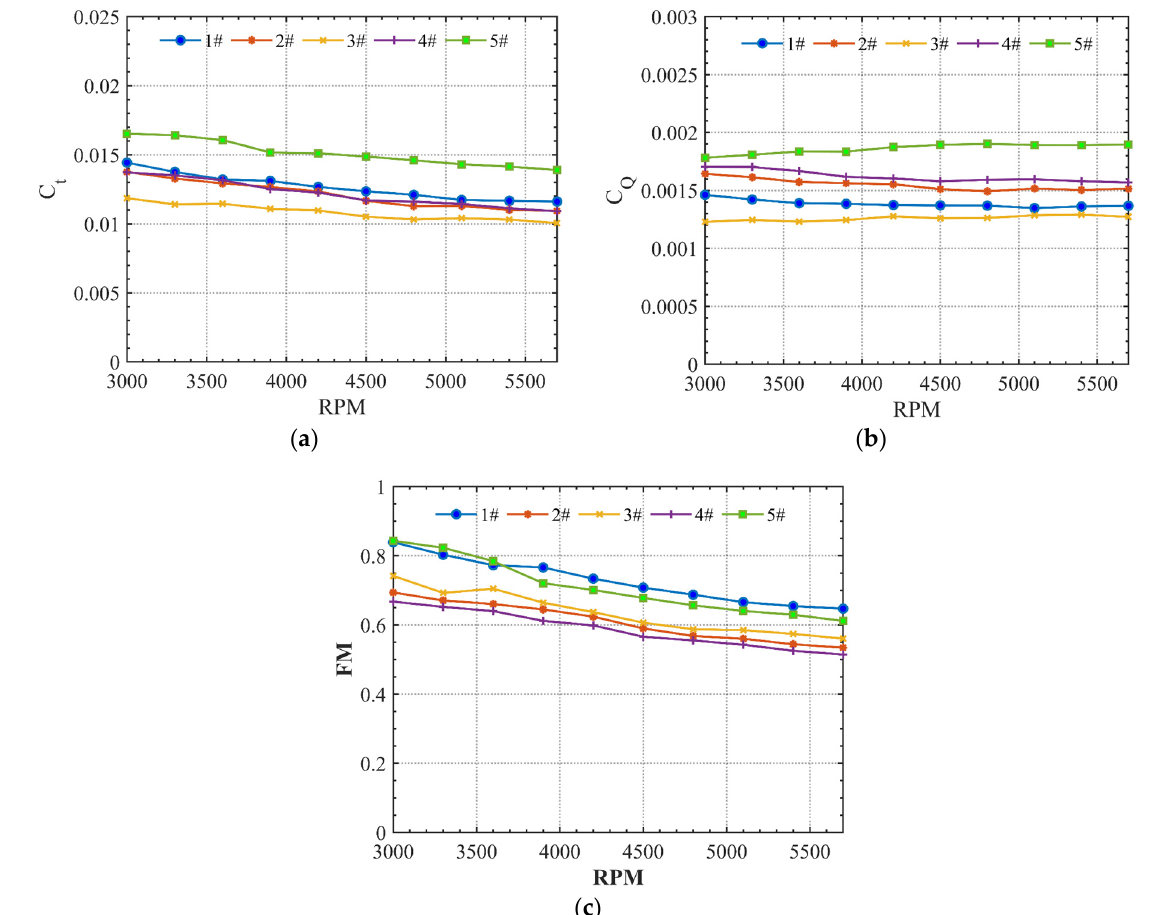
Figure 4. Comparison of ( a ) the thrust coefficient ( C t ), ( b ) torque coefficient ( C Q ), and ( c ) figure of merit (FM) among the two-blade propeller (#1), four-blade propeller (#2), loop-type propeller (#3), wide chord loop-type propeller (#4), and DJI Phantom III propeller (#5).